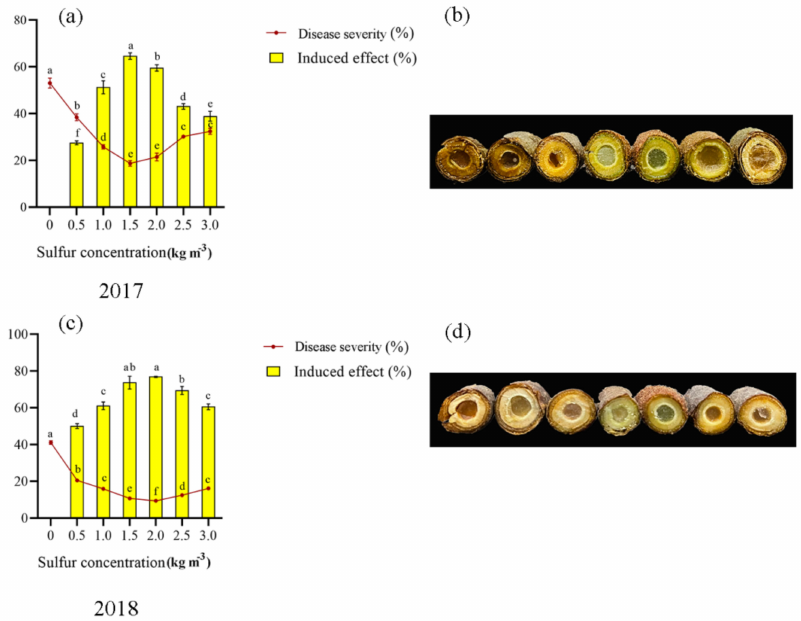
Figure 1. Induction effect on kiwifruit canker of sulfur. ( a ) Disease severity of kiwifruit canker disease and induce effect of sulfur in 2017; ( b ) Phenotypic map of kiwifruit stem canker disease after different sulfur treatments in 2017; ( c ) Disease severity of kiwifruit canker disease and induce effect of sulfur in 2018; ( d ) Phenotypic map of kiwifruit stem canker disease after different sulfur treatments in 2018. Note: Different lowercase letters indicate significant differences between different sulfur treatments at p <